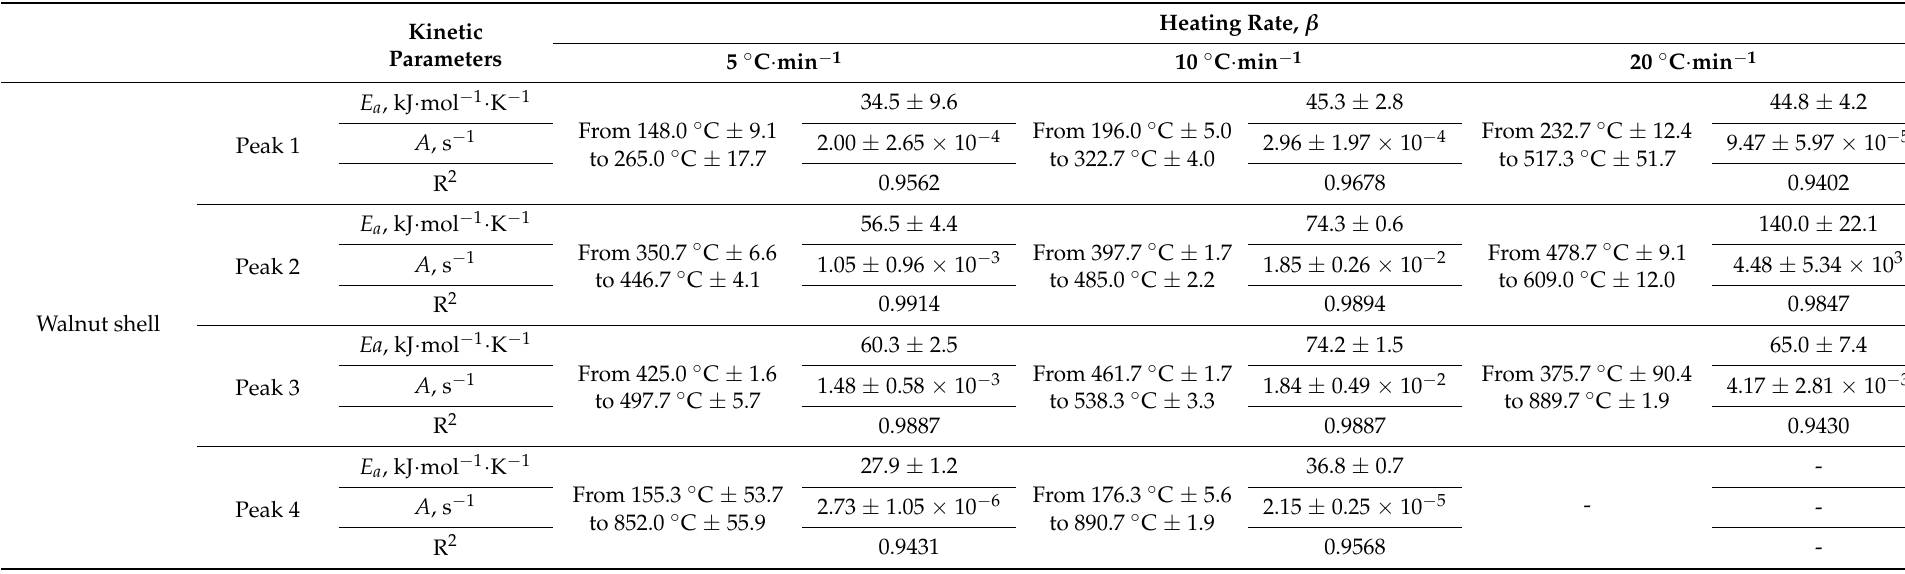
Table 5. The activation energy ( E a ) [kJ · (mol · K) − 1 ] and pre-exponential factor (A) [s − 1 ] for the WS fitted peaks. Kinetic